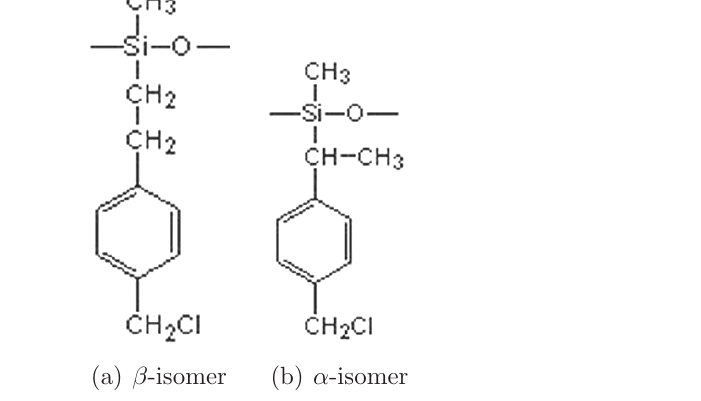
α - and β -type structural units, corresponding to the polysiloxane containing chlorobenzyl groups.